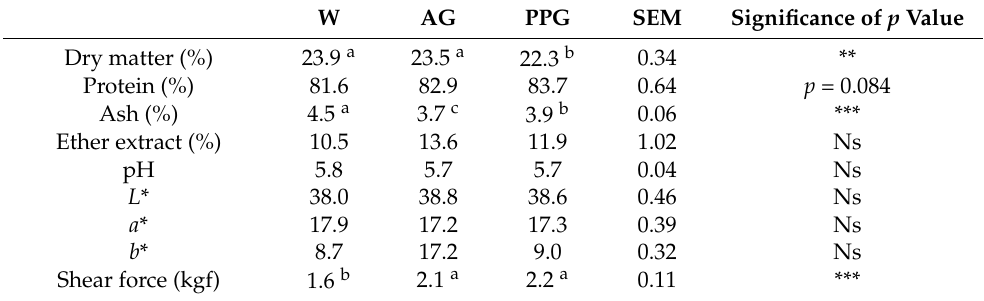
Table 6. Chemical and physical characteristics of lambs fattening on different production systems.